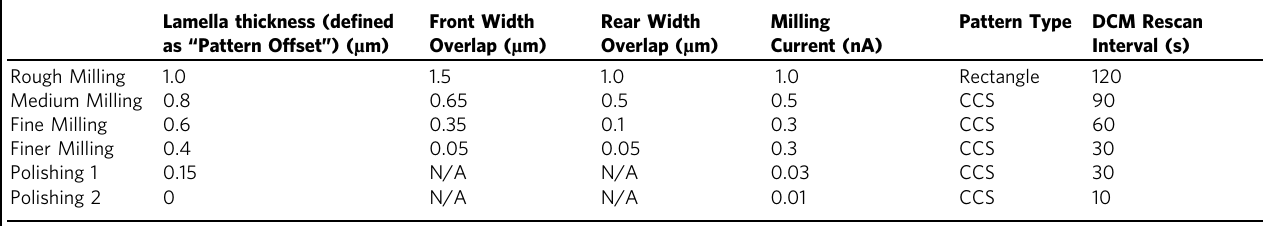
Table 2 AutoTEM Cryo 2.2 FIB-milling and thinning parameters on the Aquilos 2. Lamella thickness (de fi ned as “ Pattern Offset ” ) ( µ